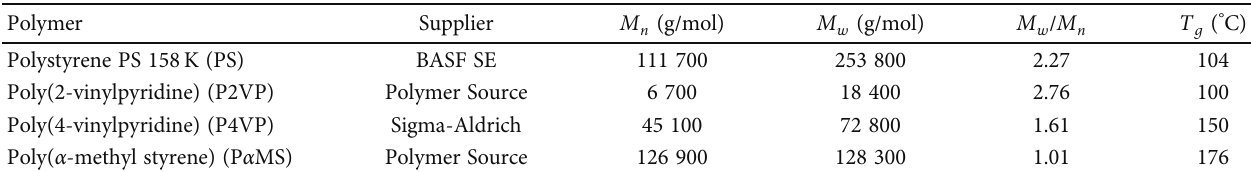
and M ) and glass transition temperature ( T n w